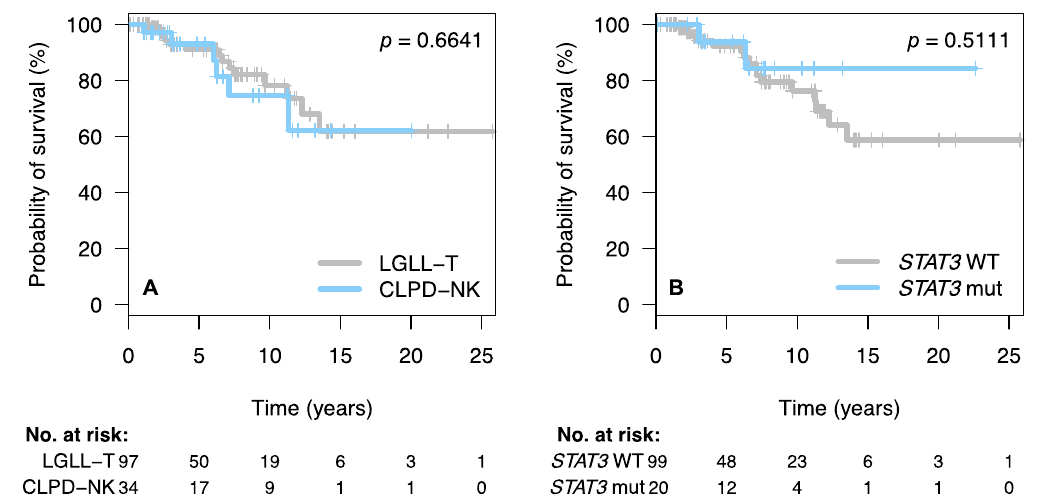
Figure 2. Overall survival of the patients of the series according to WHO diagnosis ( A ) and mutational status of STAT3 ( B ). Finally, we compared the relative survival (RS) of T-LGLL and CLPD-NK patients with that of the sex- and age-matched general Spanish population. The 10-year RS was 93%, with no significant decrease in life expectancy with the current follow-up (Figure 3).